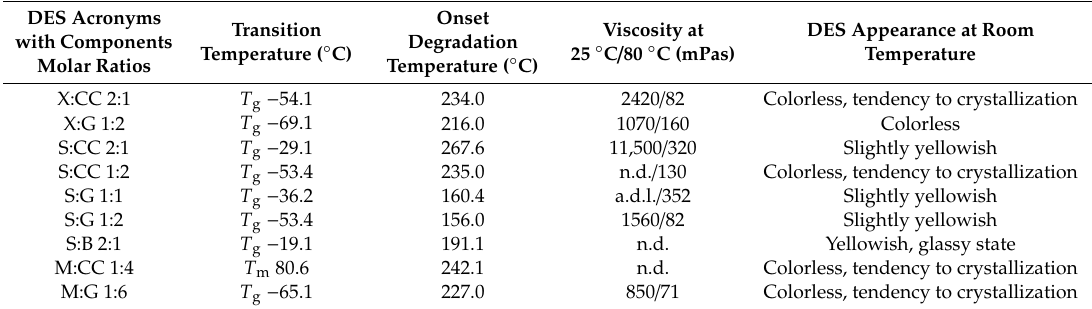
Table 2. Transition temperatures of deep eutectic solvents (DES) analyzed by di ff erential scanning calorimetry (DSC) and optical